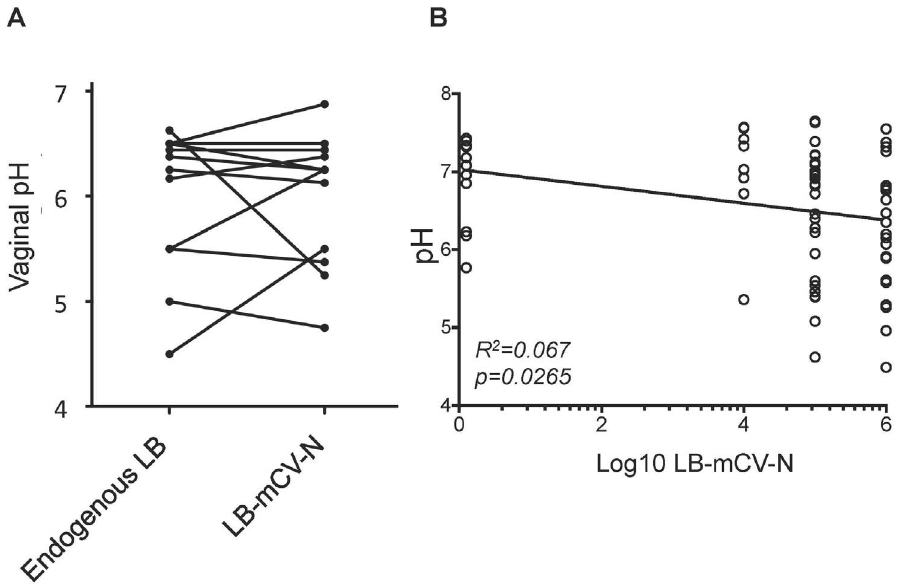
Figure 2. Influences of Lactobacillus on the vaginal pH of macaques. A) Vaginal pH was the same for macaques colonized with LB-mCVN or endogenous LB. Macaques colonized with endogenous Lactobacillus (LB) followed by colonization with LB-mCV-N had similar pH, no statistical different was noted in the vaginal pH with the different Lactobacillus species. B) Vaginal pH was measured and plotted against the levels of colonization with LB-mCV-N. Values on the far left represent times when macaques had no LB-mCV-N, and the other values are log levels of colony forming units (CFUs) of LB-mCV-N. Lower pH trended with LB-mCV-N. By simple linear regression, lower pH trended with LB-mCV-N (R 2 =0.067, slope p=0.027). Macaques that were colonized with the highest levels of LB-mCV-N, at least 10 6 colony forming units (CFU), were lower by an estimated